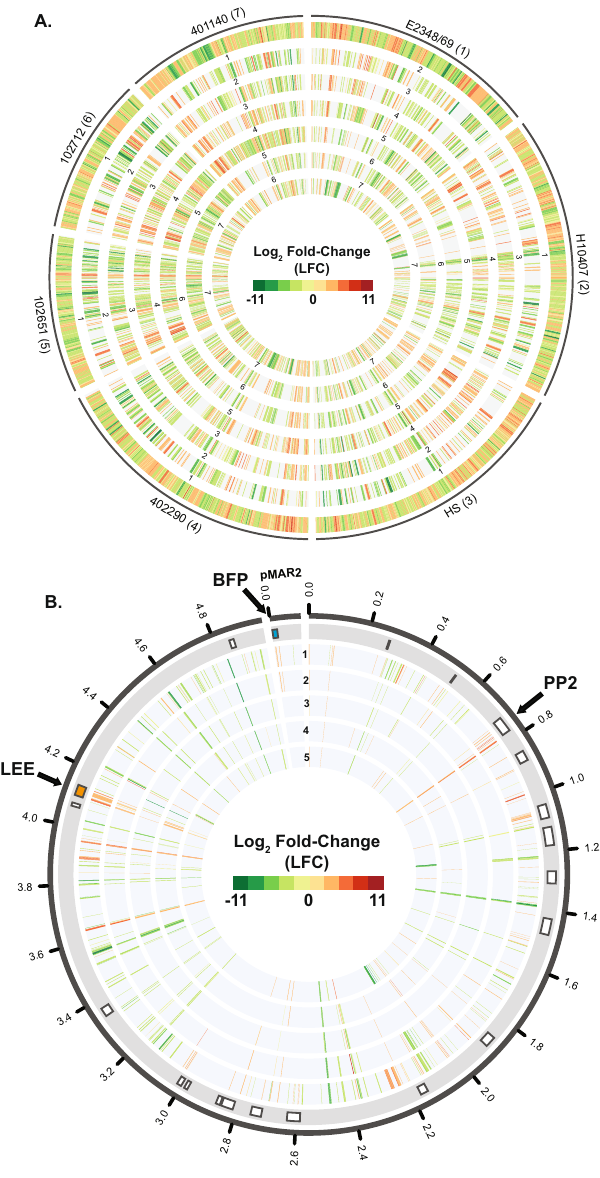
Figure 4. Comparative transcriptomics of the EPEC/ETEC hybrid isolates with representative EPEC and ETEC isolates. ( A ) Circos plot comparing the global transcriptomes of the EPEC/ETEC isolates (102651, 102712, and 401140) with representative E. coli isolates (H10407 (ETEC), HS (commensal), E2348/69 (EPEC1), and 402290 (EPEC7)) during growth in DMEM compared to LB. The outermost track contains all of the genes that exhibited significant differential expression for each of the indicated nine EPEC isolates. The inner tracks contain the LFC values of the same LS-BSR gene cluster as the gene in the outermost reference track, and the number of each of the inner tracks indicates the E. coli isolate designated in the outer track. The genes that were not present in the other EPEC isolates, or did not exhibit significant differential expression are absent from the inner tracks. ( B ) Circos plot comparing the global transcriptomes of only the EPEC isolates. The RNA-Seq data tracks are numbered as follows: E2348/69 (1), 402290 (2), 102651 (3), 102712 (4), and 401140 (5). The boxes in the outermost track indicate the location of insertion element and prophage (PP) regions in the chromosome of E2348/69 27 . The LEE region (orange) of the chromosome and BFP of the plasmid, pMAR2 (blue) are indicated by arrows. Data tracks 2–5 contain the LFC values of the same LS-BSR gene cluster as the genes of E2348/69 (track 1) that exhibited significant differential expression. The genes that were not identified in the other EPEC isolates, or did not exhibit significant differential expression are absent from tracks